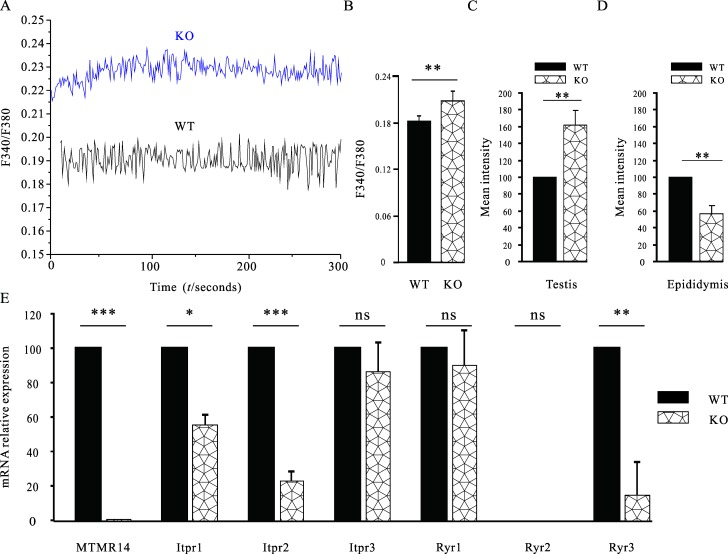
Deficiency of MTMR14 impaired the homeostasis of [Ca2+]i.(A) Basal [Ca2+]i in WT and KO spermatogenic cells were measured by calcium imaging system (n = 8). Representative data are shown. The X axis represents time (seconds), and the Y axis represents the ratio of F340 to F380. (B) Statistical data of (A) (n = 40 cells). **: P < 0.01. (C) The spermatogenic cells from WT or MTMR14-/- mouse testes were stained with Fura-2 AM at a final concentration of 20 μM for 30 min. The mean fluorescence intensity was monitored by flow cytometry, calculated and shown (n = 4). **: P < 0.01; (D) Sperm from WT and MTMR14-/- mouse epididymides were isolated to evaluate the concentrations of their [Ca2+]i, which was analysed using flow cytometry. Statistical data are shown (n = 4). (E) Real-time PCR was used to detect the relative mRNA expression levels of three IP3 receptors (Itpr1, Itpr2, and Itpr3) and three ryanodine receptors (Ryr1, Ryr2, and Ryr3) in WT and MTMR14-/- mice testes. *: P < 0.05, **: P < 0.01, ***: P < 0.001, ns: no statistic difference. These results demonstrated that MTMR14 regulates the homeostasis of [Ca2+]i, suggesting that MTMR14 was involved in regulating spermatogenesis and fertilization.